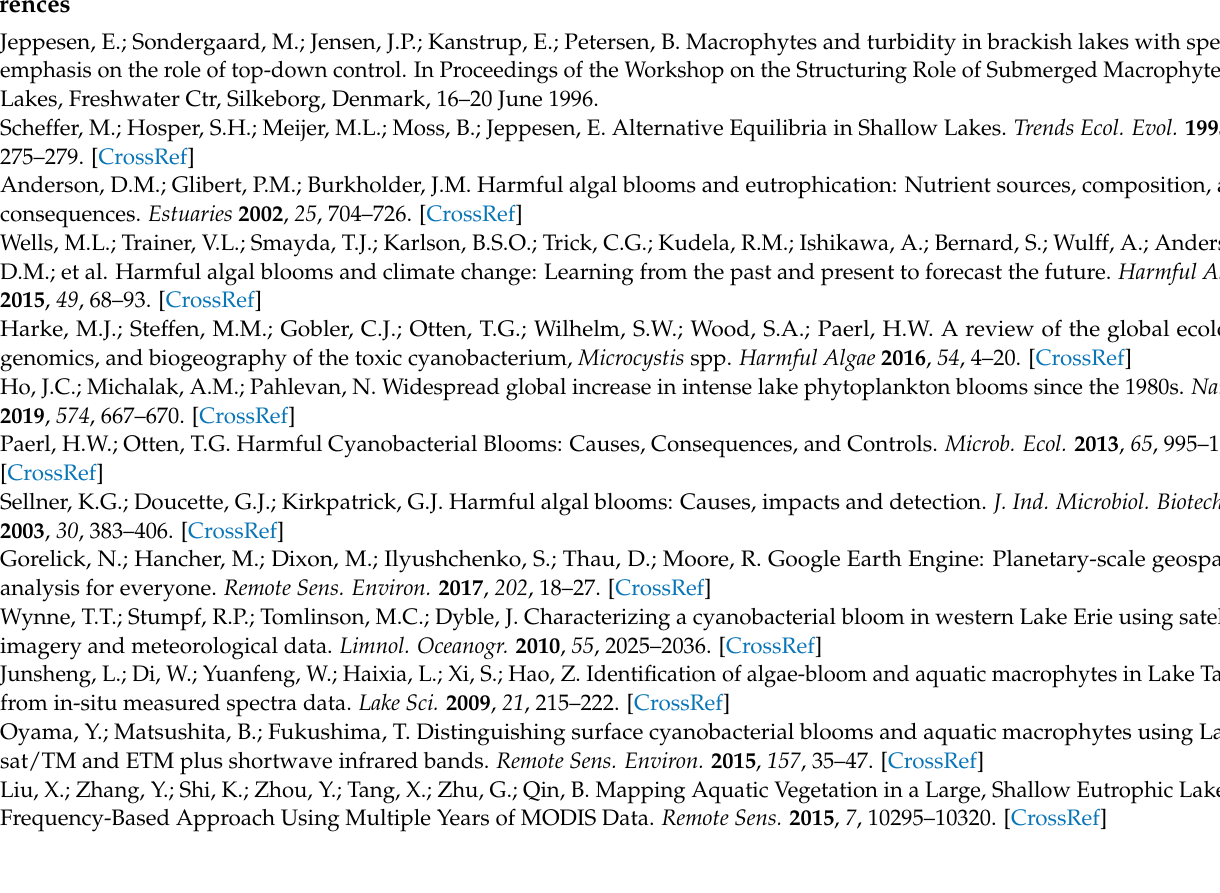
figure (b) vegetation group, black curve for normal algal blooms, blue curve for inconspicuous algal blooms (marginal areas of algal blooms) and red curve for submerged vegetation; Table S1: